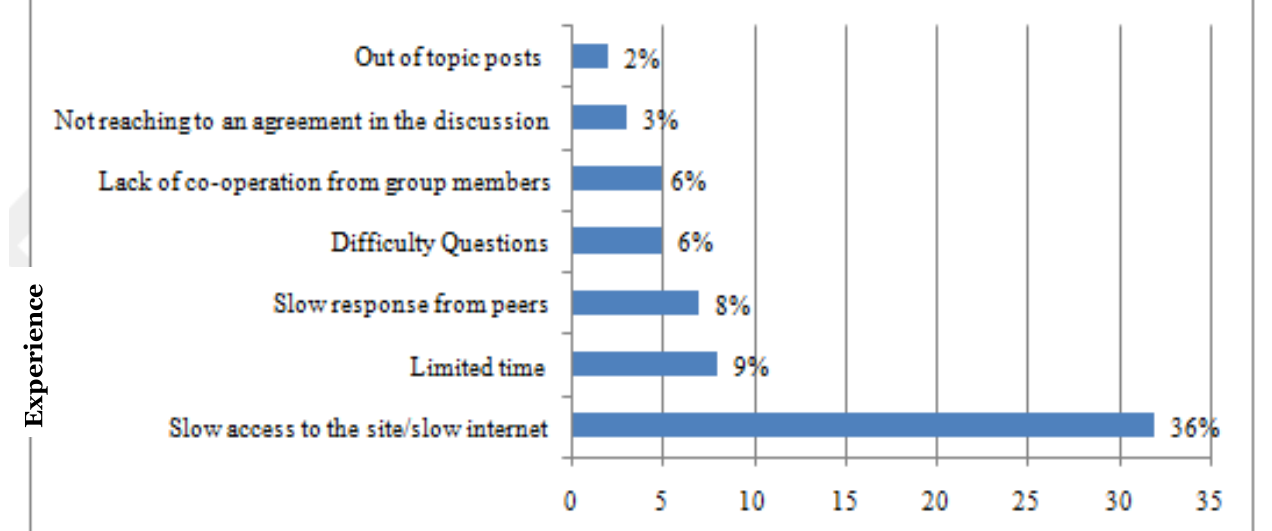
Figure 2 . Best learning experiences from the discussion